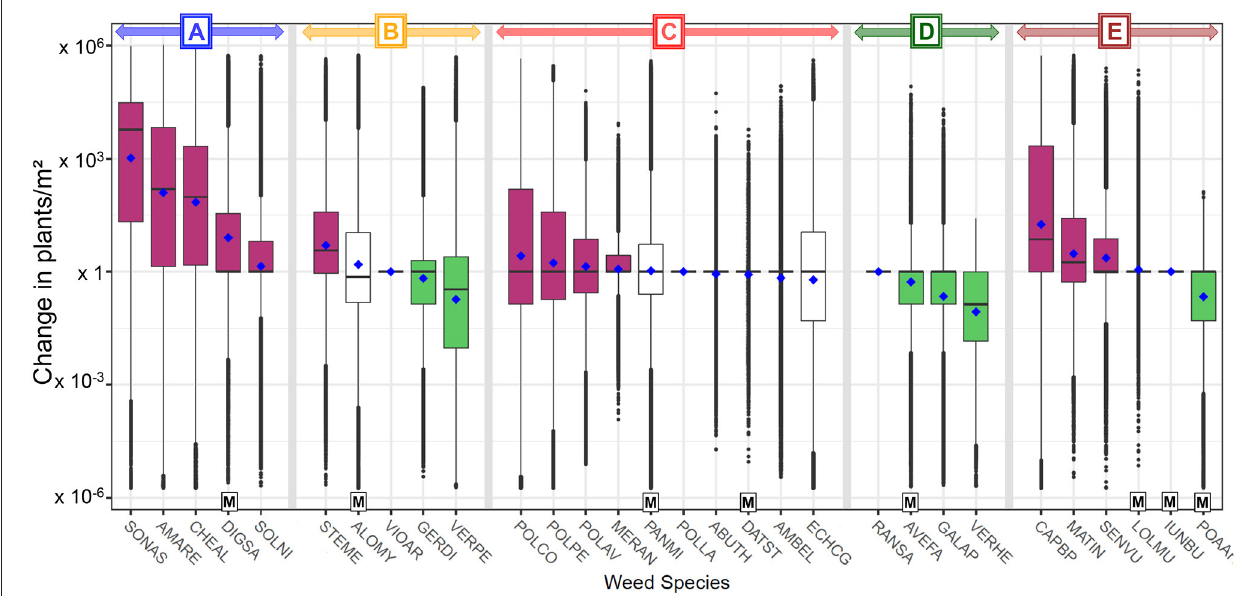
FIGURE 4 | Variation in weed plant densities when deleting tillage without compensation in the 395 systems × 30 years × 10 weather repetitions. Weed species are ordered according to decreasing change in densities and named with their EPPO codes, for full names see Table A1 . Boxes show 25, 50 (median), and 75-percentiles of distribution, whiskers extend from the box to, respectively, the lowest and largest values no further from the box than 1.5 × the height of the box, blue diamonds are mean values. Boxes were colored in (cid:4) for species whose mean variation was significantly > 1 and whose value-distribution was skewed toward values > 1 (and vice-versa for boxes colored in (cid:4) ). Letters on top of the plot refer to species clusters established during the RLQ analysis of Figure 5 .